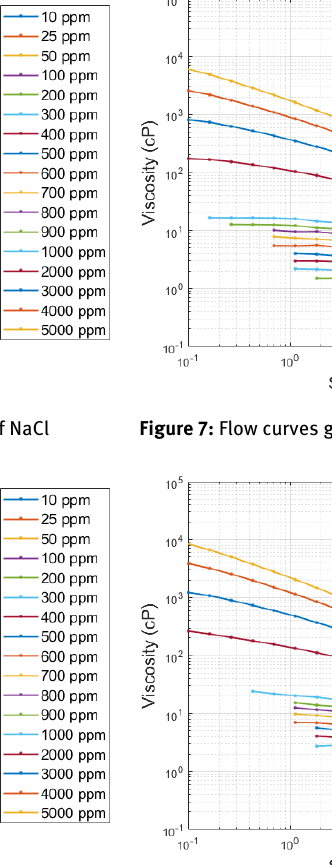
Figure 8: Flow curves graph at 50 ∘ C and 220,000 ppm of